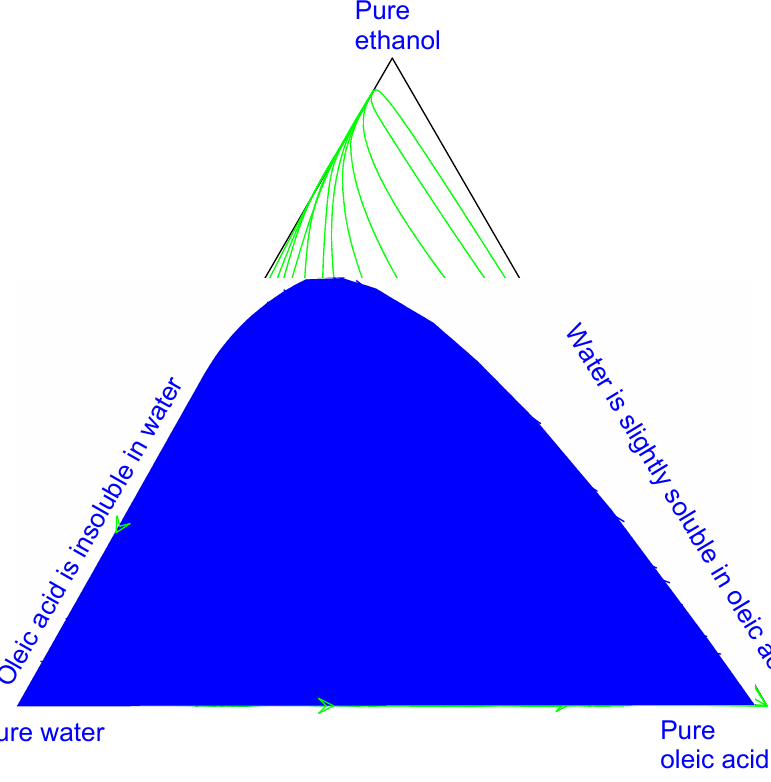
Figure 10. Residue curve map for the mixture oleic acid-water-ethanol.